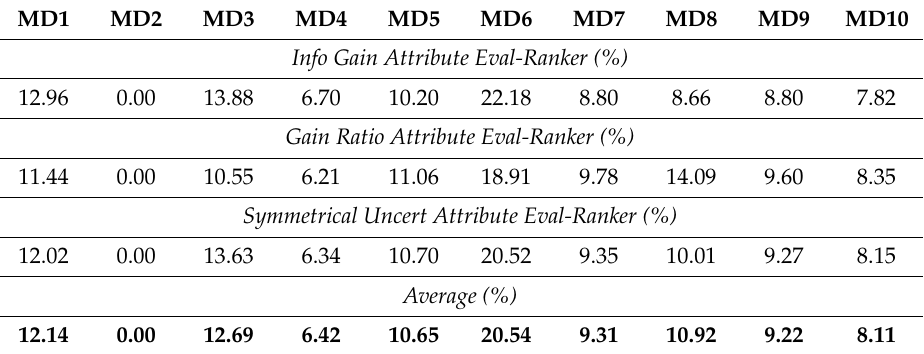
Table 5. Contribution of molecular descriptors to the anti-HIV SAR study. Average values are mentioned in the bottom of the